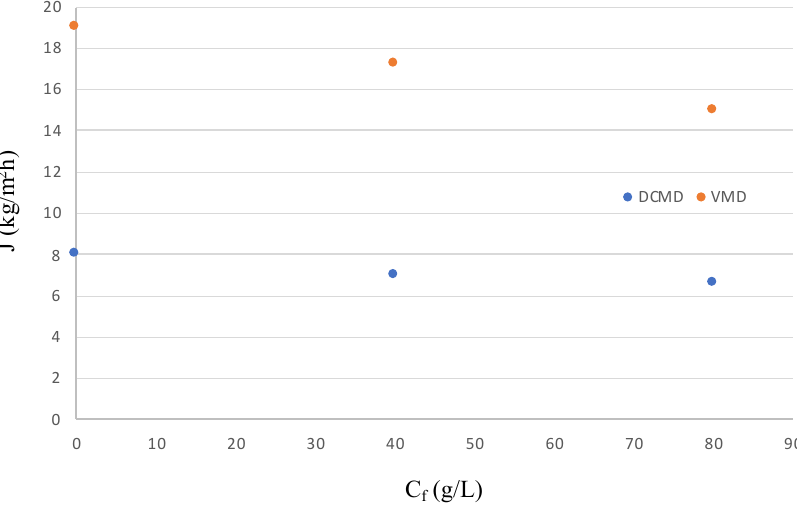
Table 2. Comparison of DCMD and VMD operating on the 80 g/L brine . MD Configuration